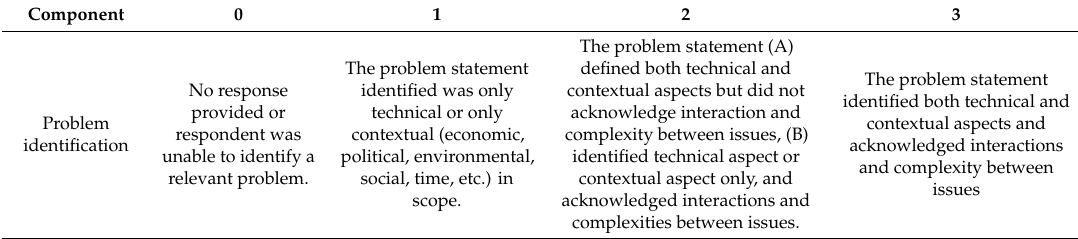
Table A1. Systems thinking writing rubric